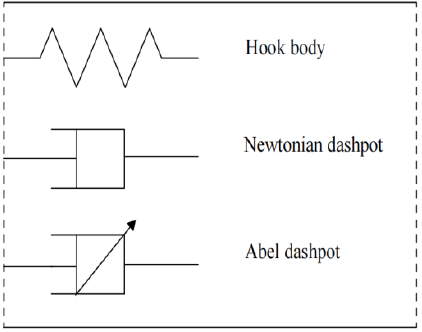
Figure 6. The basic mechanical elements.